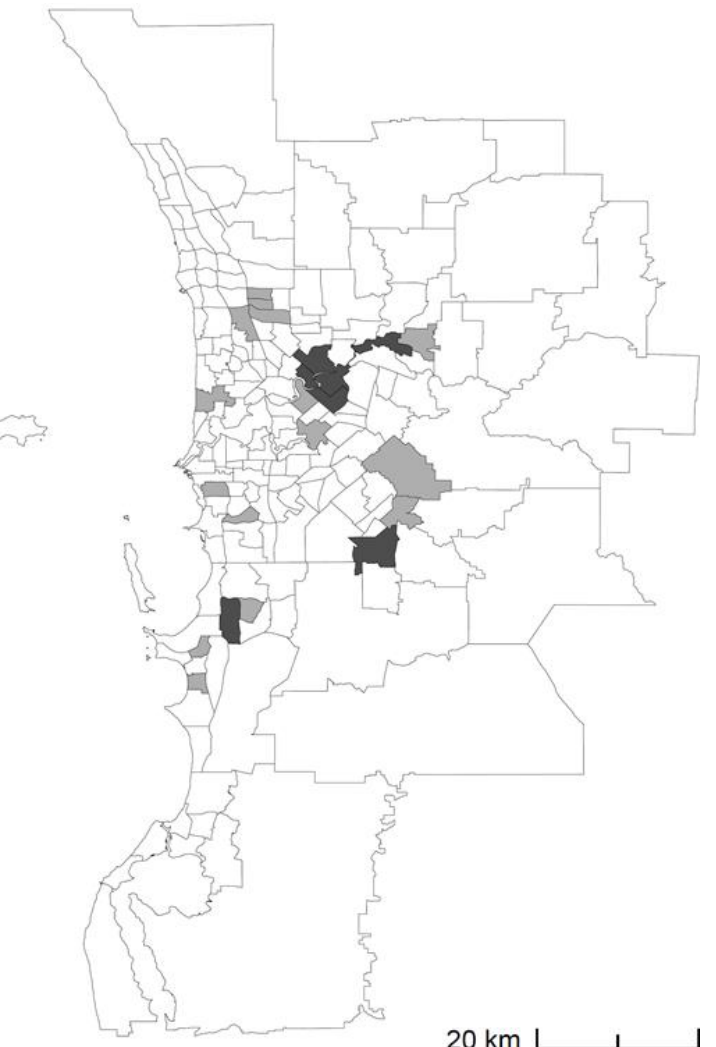
Figure 5. Hotspot SA2s for high-risk foot (HRF) in metropolitan Perth in 2011–2012 (all shaded areas), and the subset of seven of these that were classified as hotspots for six or more consecutive years up until 2011–2012 (inclusive; shaded dark grey).